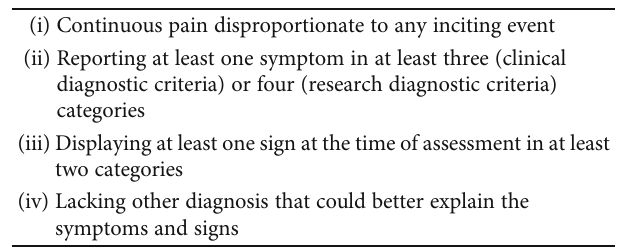
Table 1: Budapest diagnostic criteria for CRPS [11,